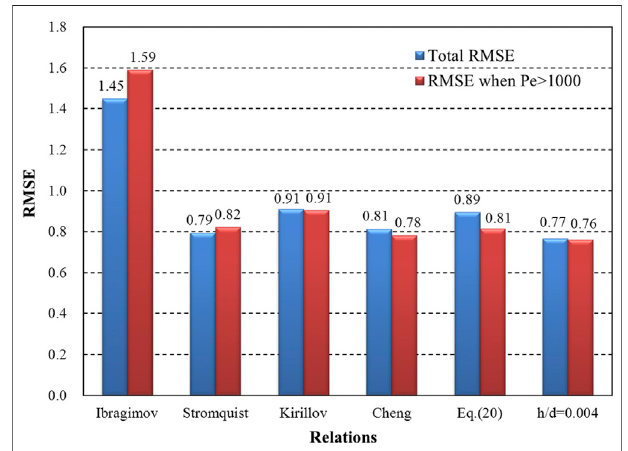
FIGURE12| RMSEvaluesforthevariousrelationswhencompared with the NCCL experimental data.